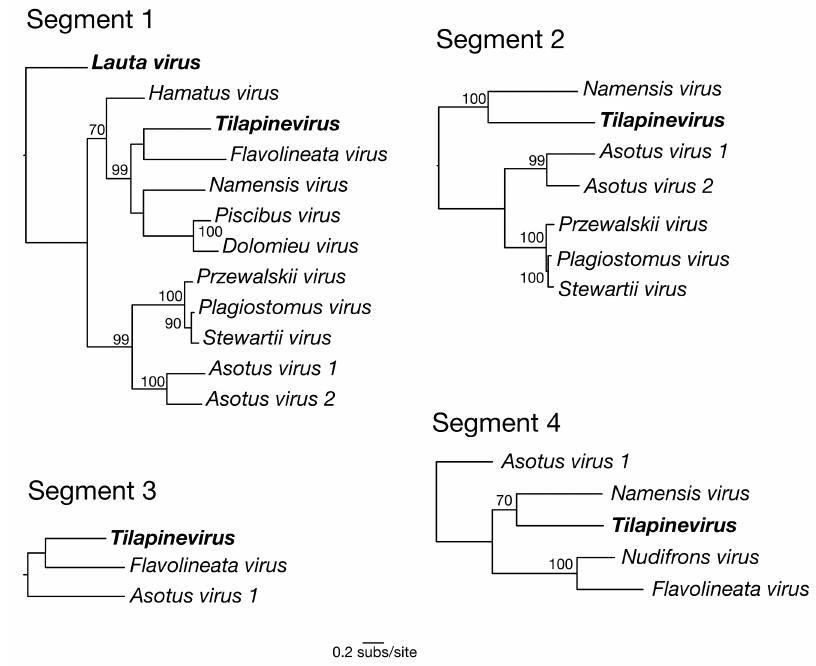
Figure 3. Maximum likelihood phylogenetic trees of genomic segments 1–4 for the new virus transcripts identified in this study within the Amnoonviridae . Viruses previously identified in this family are in bold. Bootstrap values > 70% are shown. The segment 1 phylogeny was rooted using Lauta virus as the outgroup (as suggested by the tree in Figure 2). The remaining three segment phylogenies were then rooted to match the segment 1 tree. A branch scale bar represents 0.2 substitutions per site. See Table S2 for virus sequence